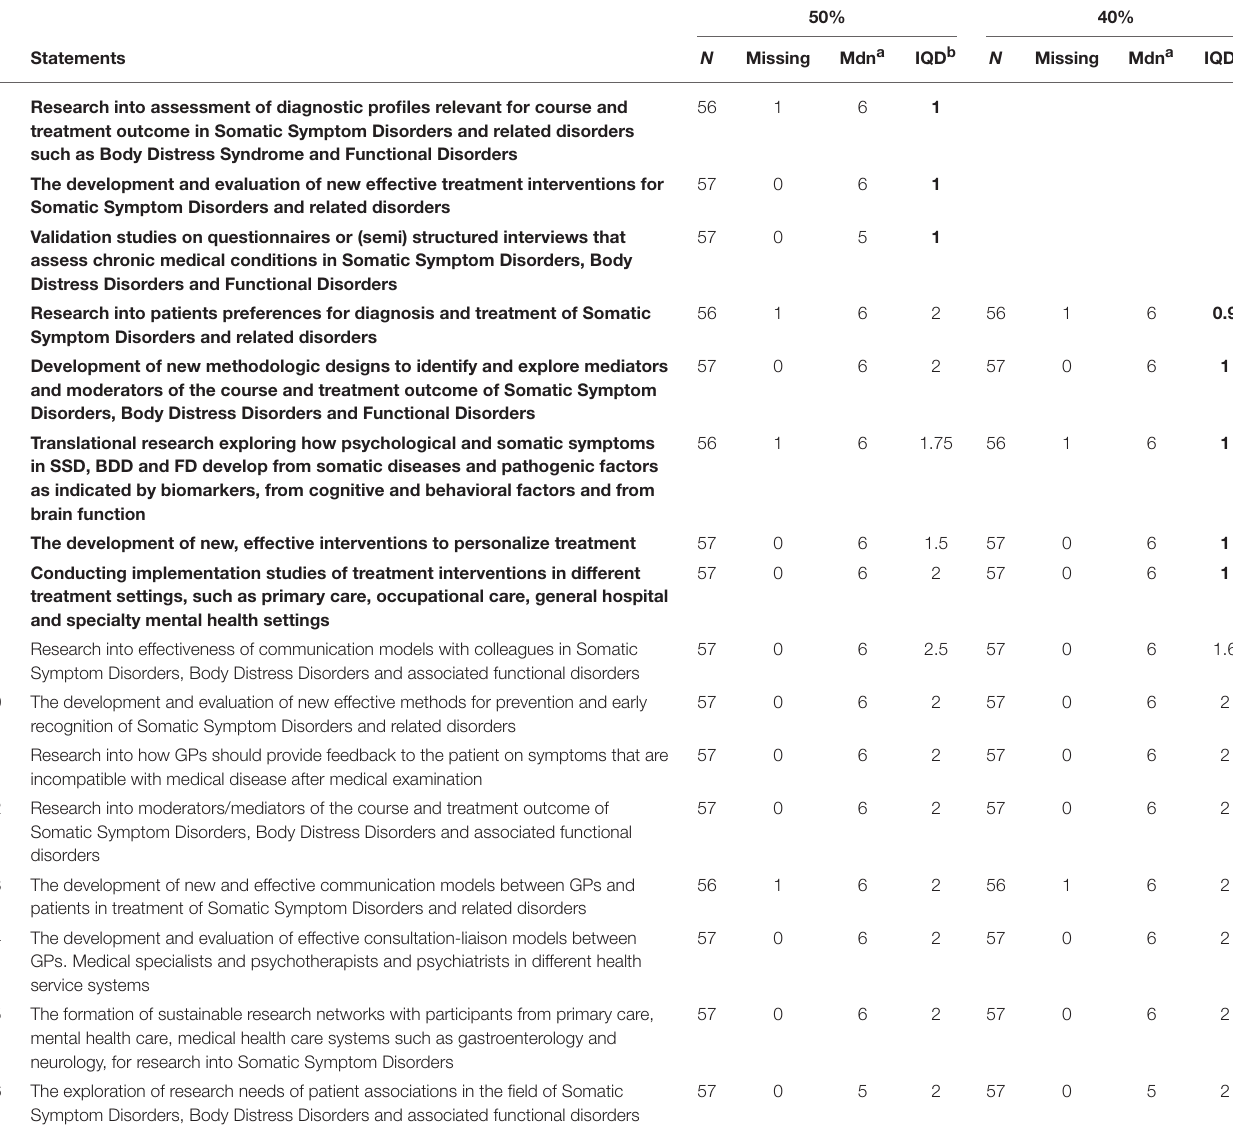
TABLE 2 | Level of consensus regarding the